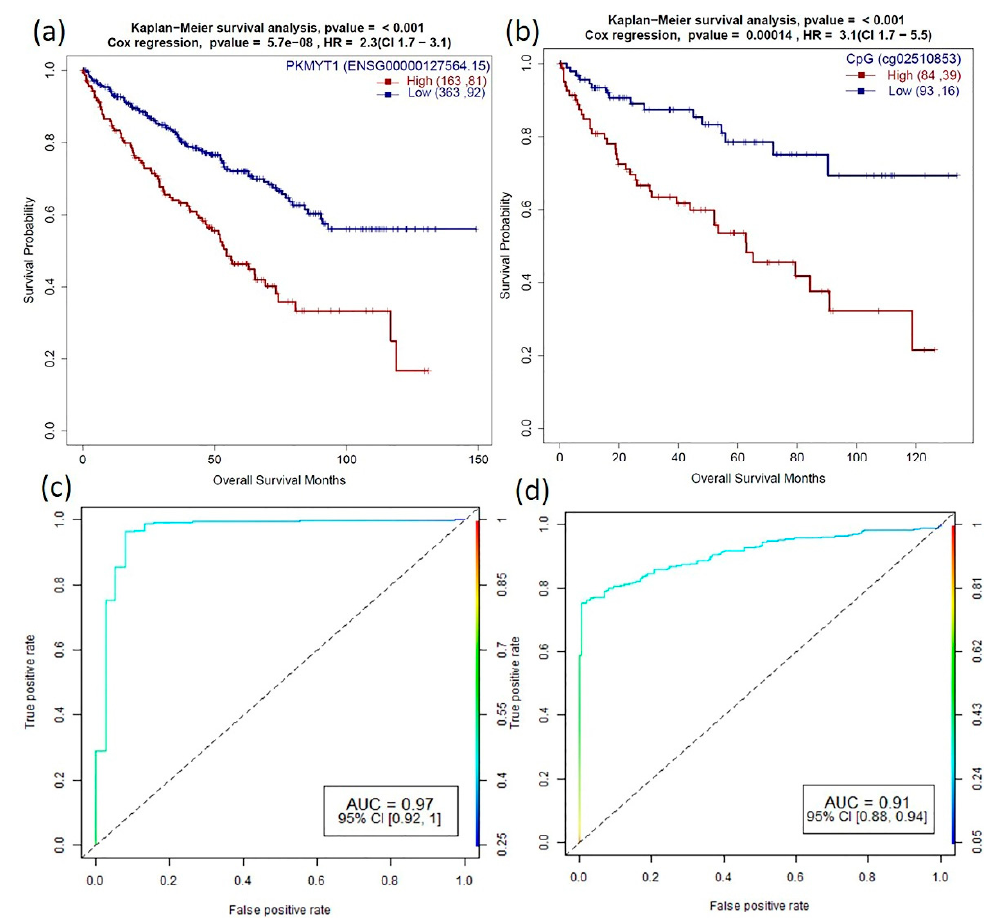
Figure 6. Role of PKMYT1 in prognosis and diagnosis ( a , b ) Survival plots of PKMYT1 high vs. low gene expression and promoter DNA methylation sites (cg02510853) which are associated with KIRC patient survival with p -value for KM plot (log-rank test) and Cox proportional hazard model. ( c , d ) Corresponding ROC plot of gene expression and promoter methylation for the generalized linear model.